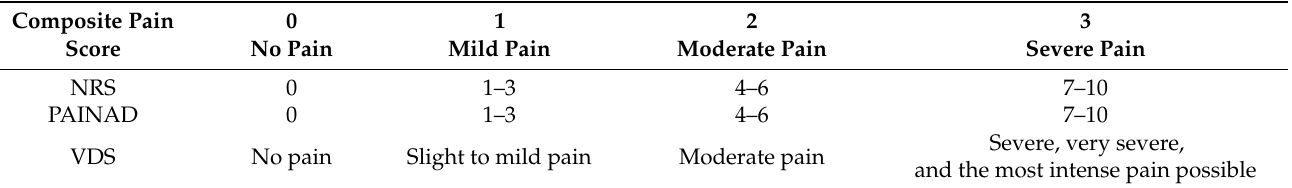
Table 1. Composite pain scores to incorporate NRS, PAINAD and